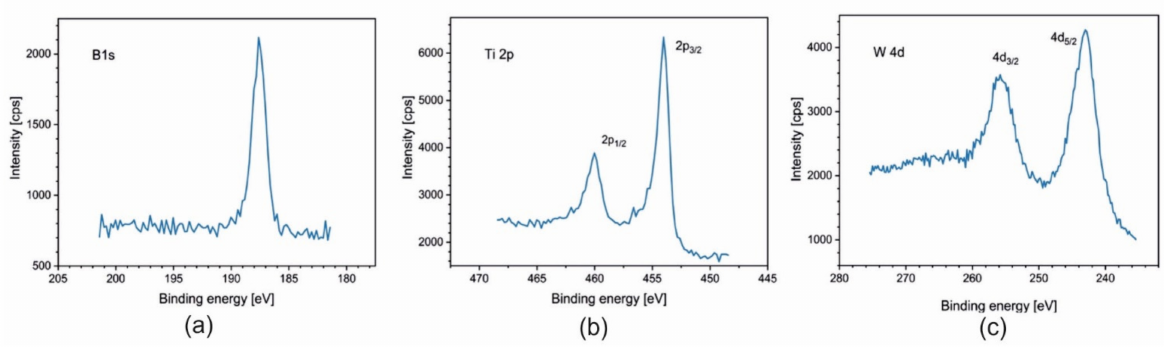
Figure 8. XPS spectra of ( a ) B 1s; ( b ) Ti 2p; and ( c ) W 4d obtained after 140 min of sputtering for the coating Ti 0.5 W 0.5 B 2